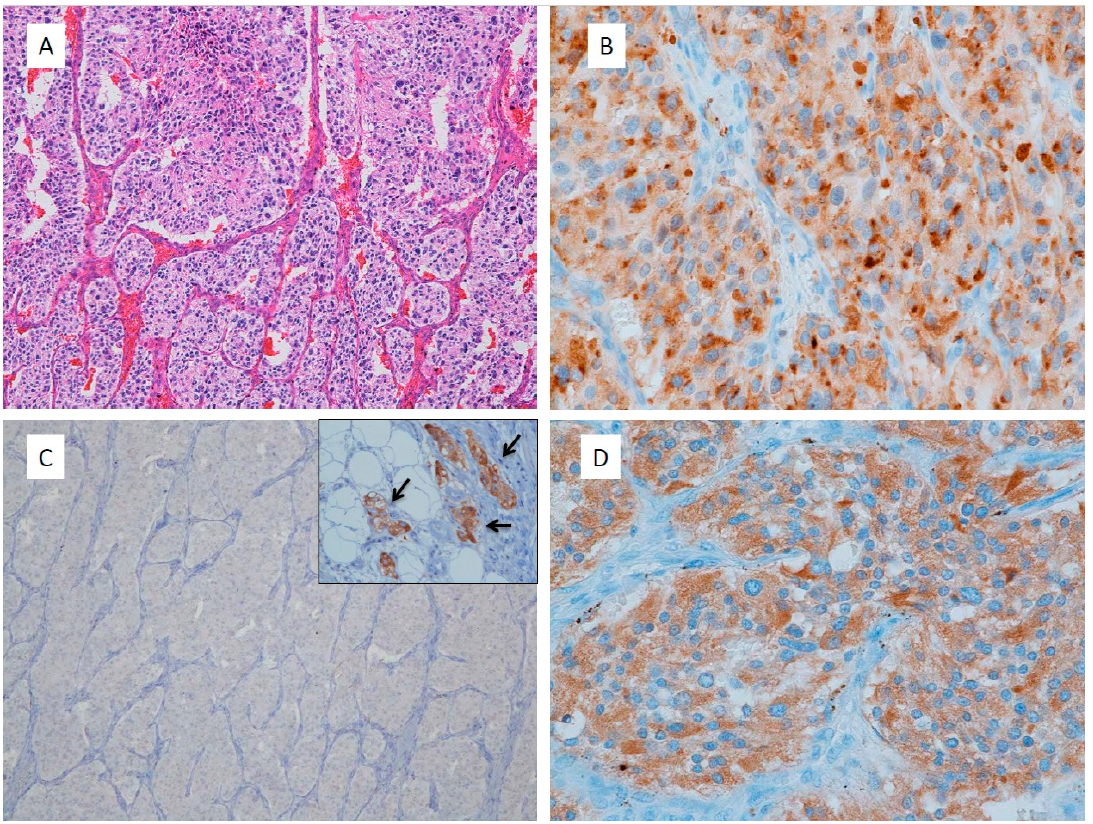
Figure 1. Non-functioning retroperitoneal paraganglioma. ( A ) This tumor shows large irregular zellballen pattern, high cellularity, comedo necrosis, vascular invasion, 14% of Ki67 labelling index and total score of CAPP is 9 points; ( B ) Chromogranin A immunostaining shows dot-like reactivity at Golgi area of tumor cells; ( C ) Tyrosine hydroxylase immunohistochemistry shows negative staining in all tumor cells. Inset is internal control of sympathetic ganglion cells adjacent to the tumor; ( D ) Dopamine beta-hydroxylase immunostaining shows positive reaction in tumor cells even like this non-functioning paraganglioma.